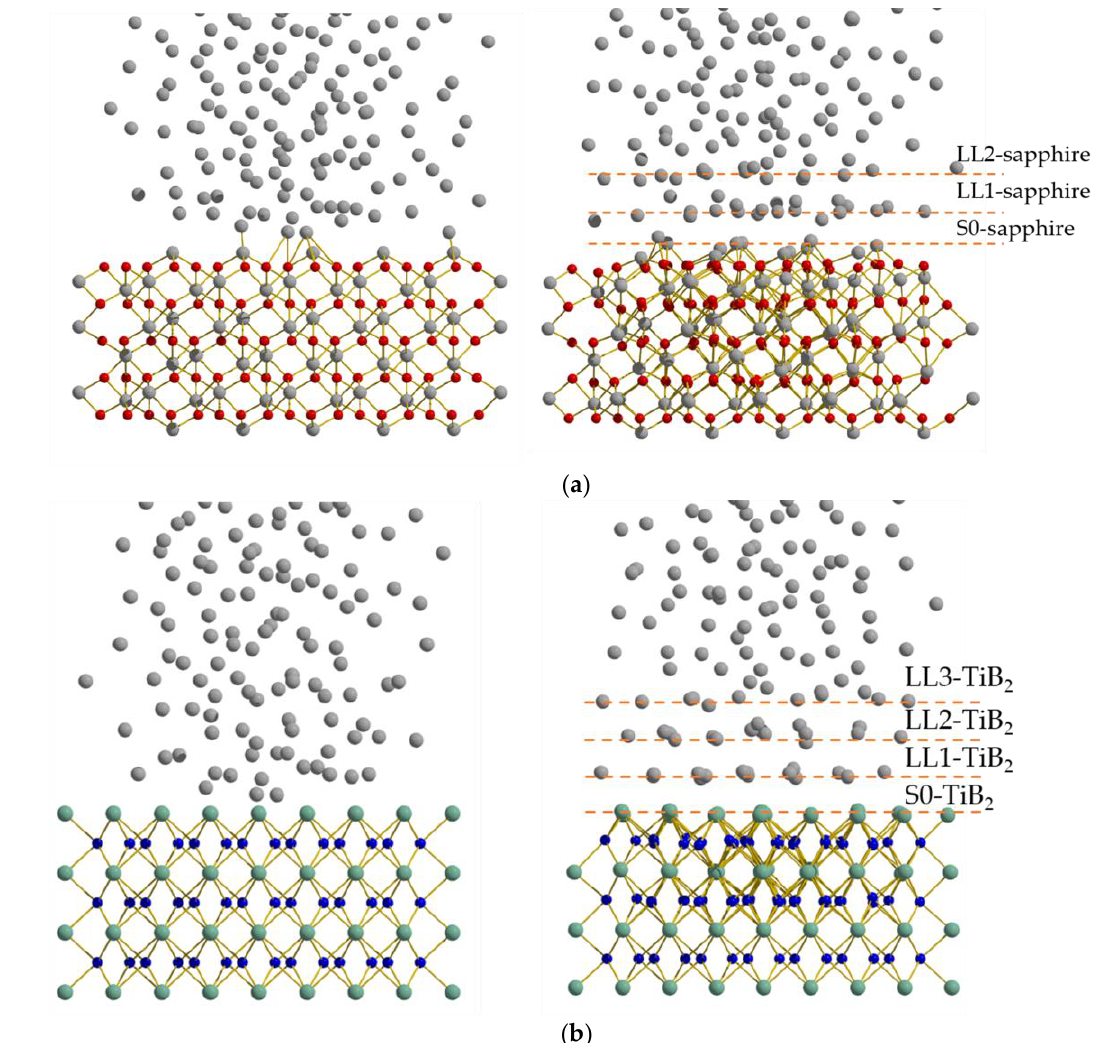
Figure 1. Initial (the left column) and evolved (the right column) solid/liquid (S/L) interfacial structure of ( a ) (0001) sapphire–liquid Al and ( b ) (0001) TiB 2 –liquid Al systems. (Al: gray spheres; O: red spheres; Ti: green spheres; B: blue spheres).